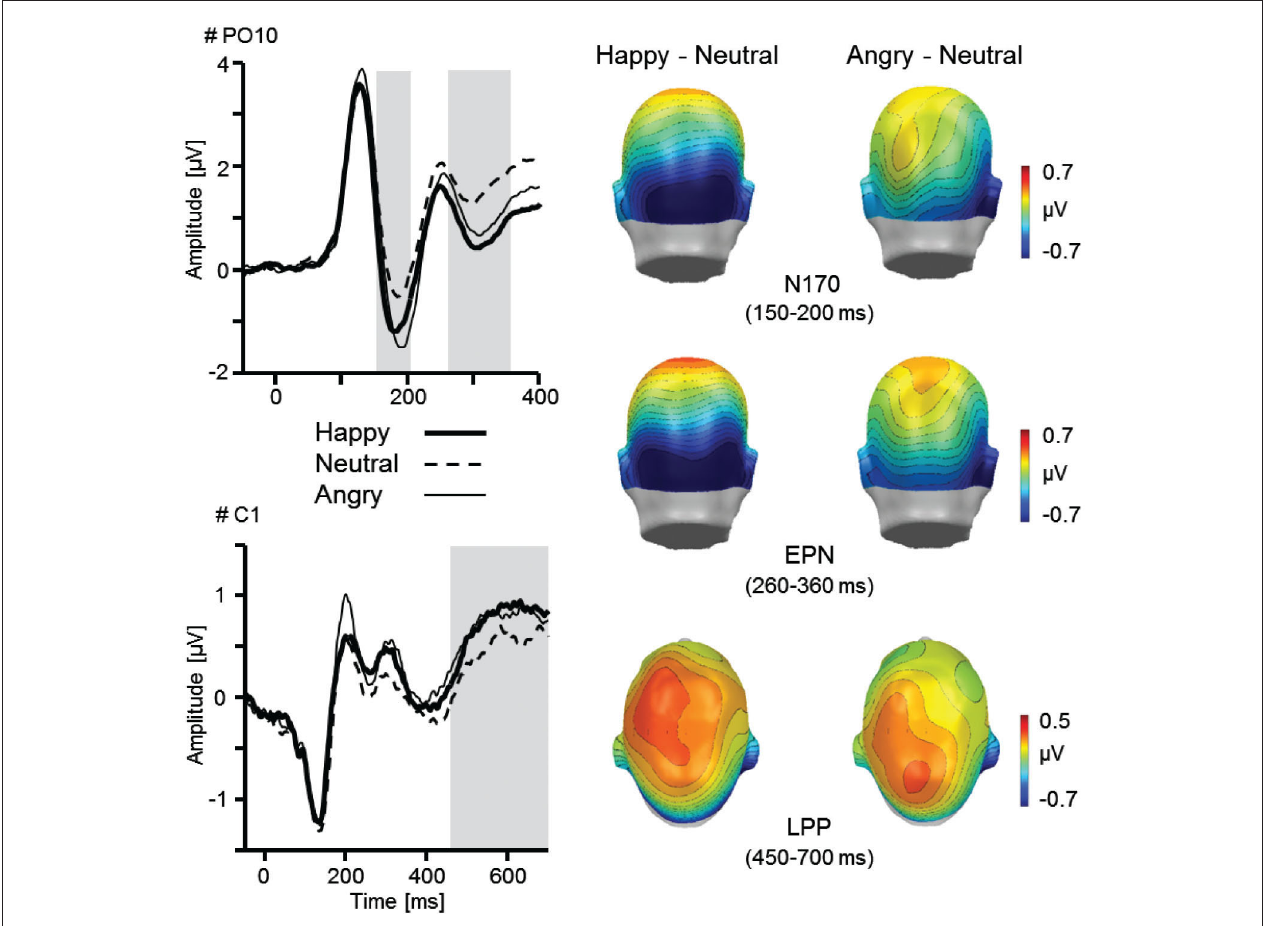
display the averaged time interval plotted on a back (N170: 150–200 ms; EPN: 260–360 ms) and top view (LPP: 450–700 ms) of a model head. Analyzed time windows are highlighted in gray (PO10: N170 and EPN; C1: LPP).